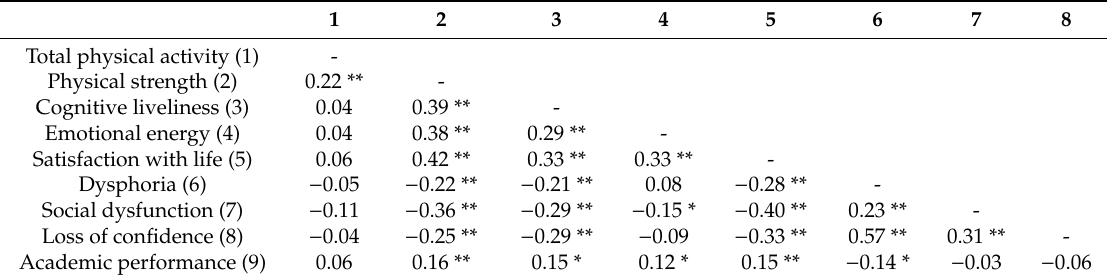
Table 3. Pearson correlation coe ffi cients.